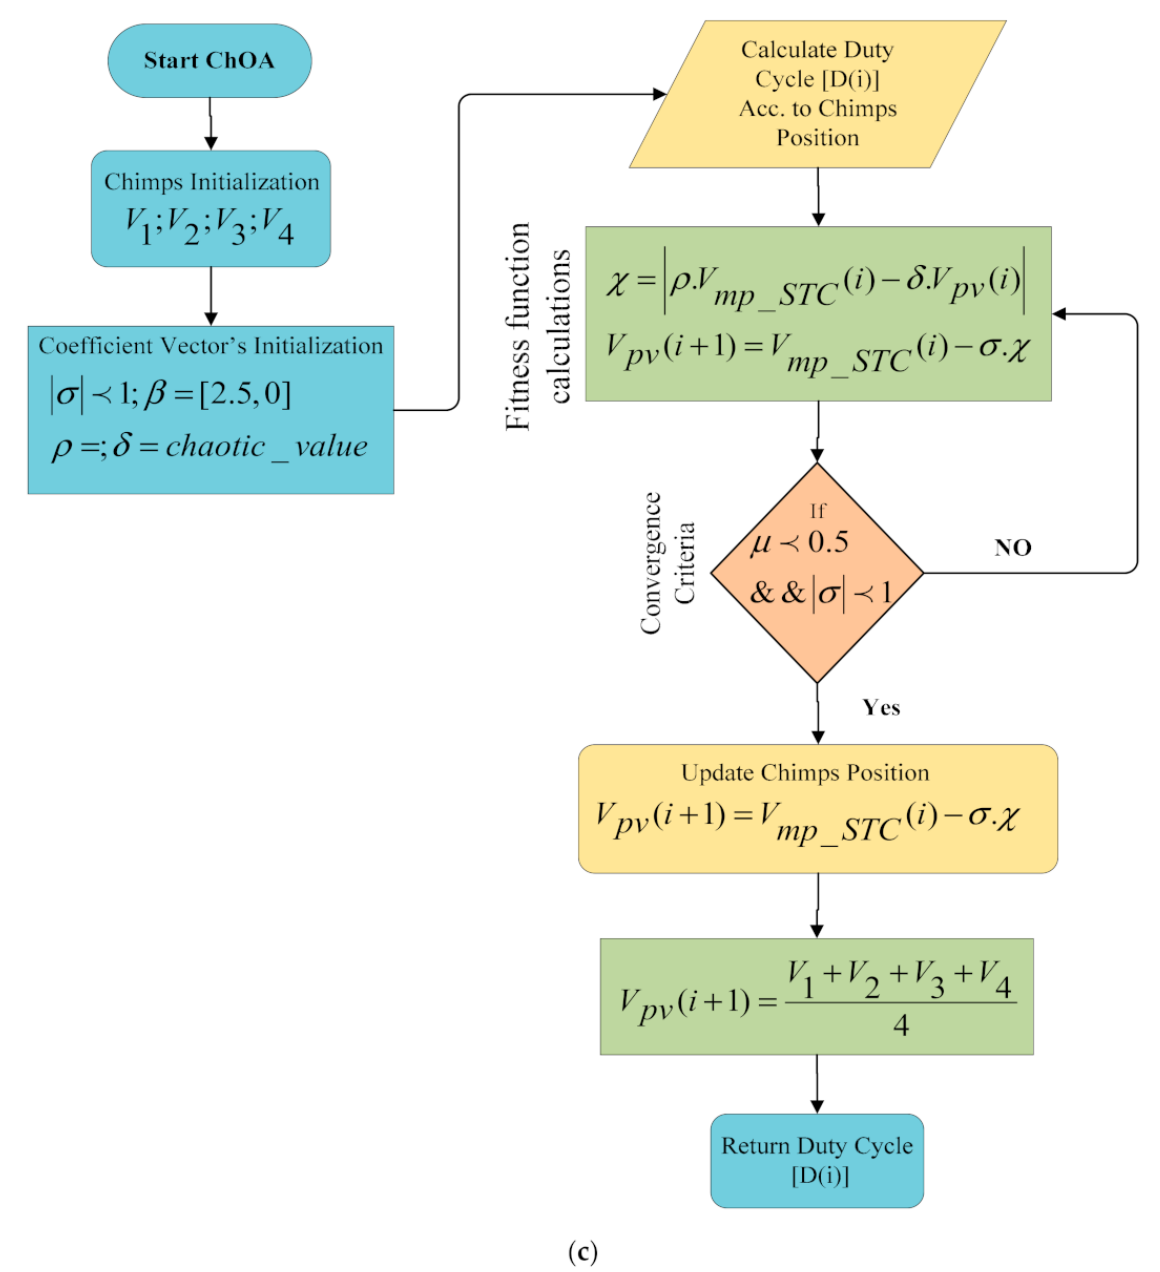
Figure 5. ( a ). Flowchart for identification of operating conditions. ( b ) Flowchart of the modified perturb and observe algorithm. ( c ) Flowchart of the chimp optimization